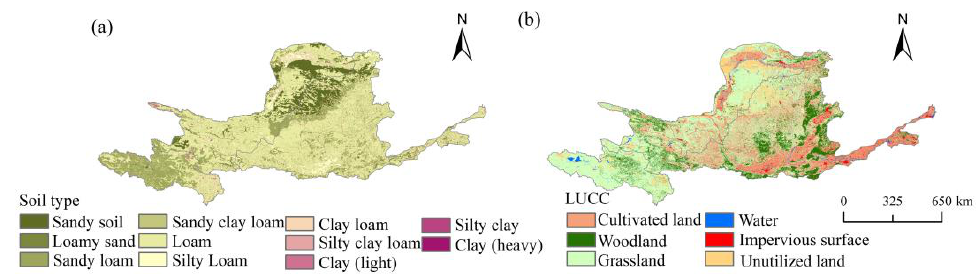
Figure 2. ( a ) Soil type and ( b ) LUCC across the Yellow River